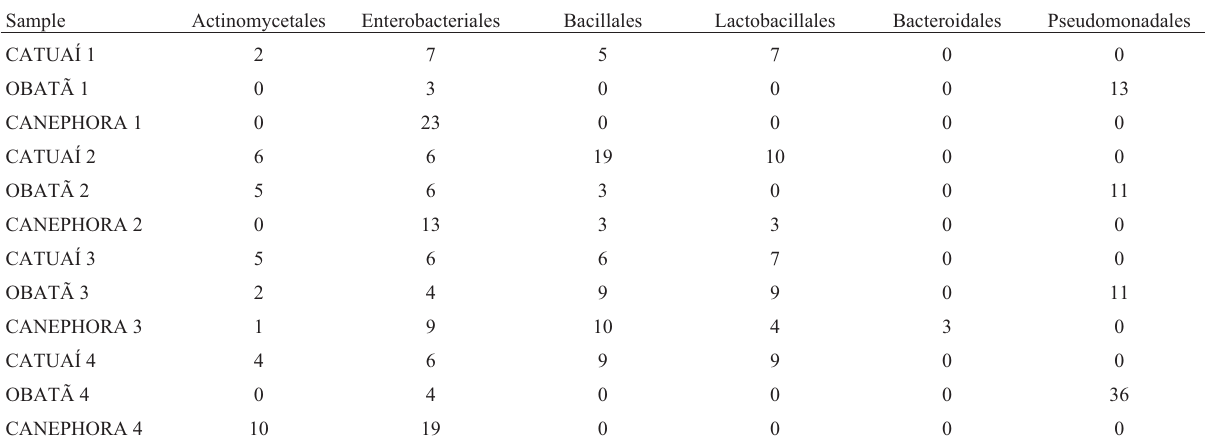
Table 1 - Abundance of OTUs associated with bacterial orders identified in the leaves of three coffee genotypes. Sample 1 – ‘rest’, sample 2 – ‘blossom’, sample 3 – ‘early fruit’, sample 4 – ‘late